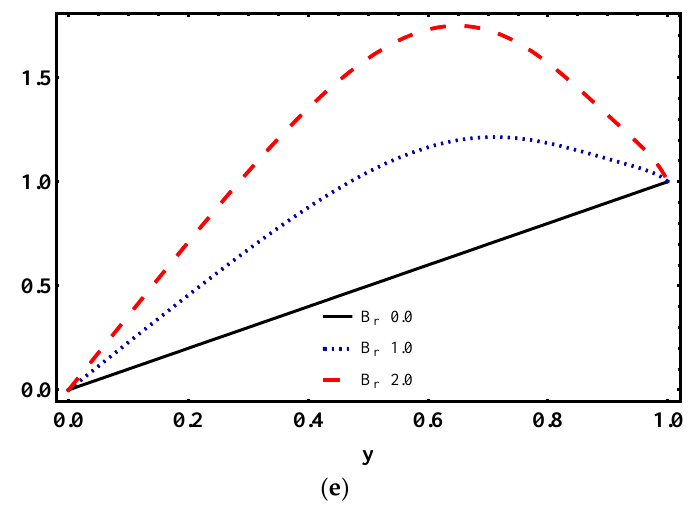
Figure 9. Temperature profile for (𝐚) . 𝑊 𝑒 (𝐛). 𝑛 𝑖 (𝐜). 𝑚 𝑒 (𝐝).𝑈 𝐻𝑆 (𝐞). 𝐵 𝑟 .